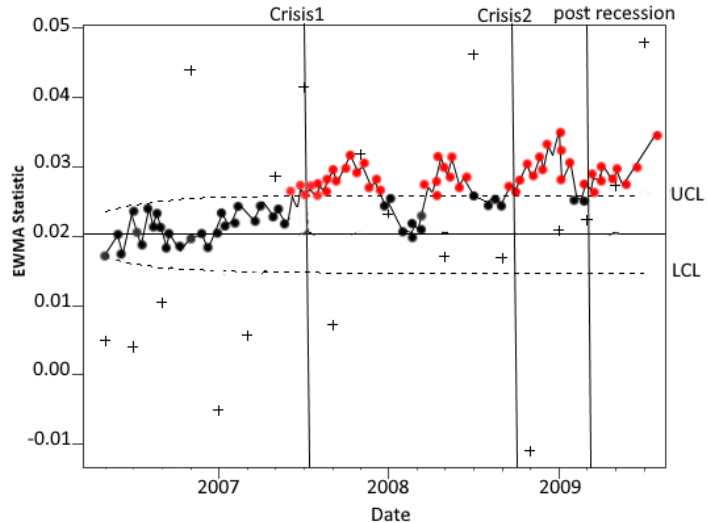
Figure 3. EWMA charts for Pearson’s residuals from the zero-inflated generalized linear mixed model to detect the onset of Crisis 1. Red dots are considered as out of control